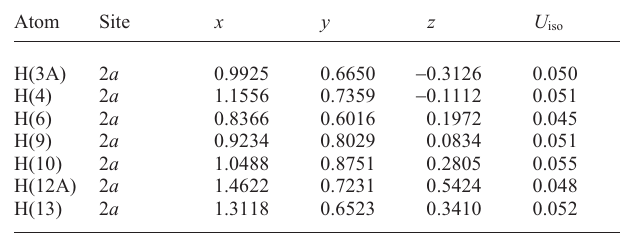
Table 3. Atomic coordinates and displacement parameters (in Å 2 )